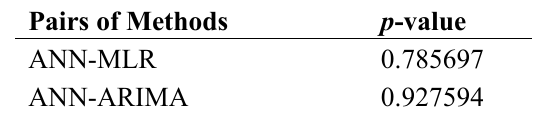
Table 7. Paired t -test for each pair of forecasting